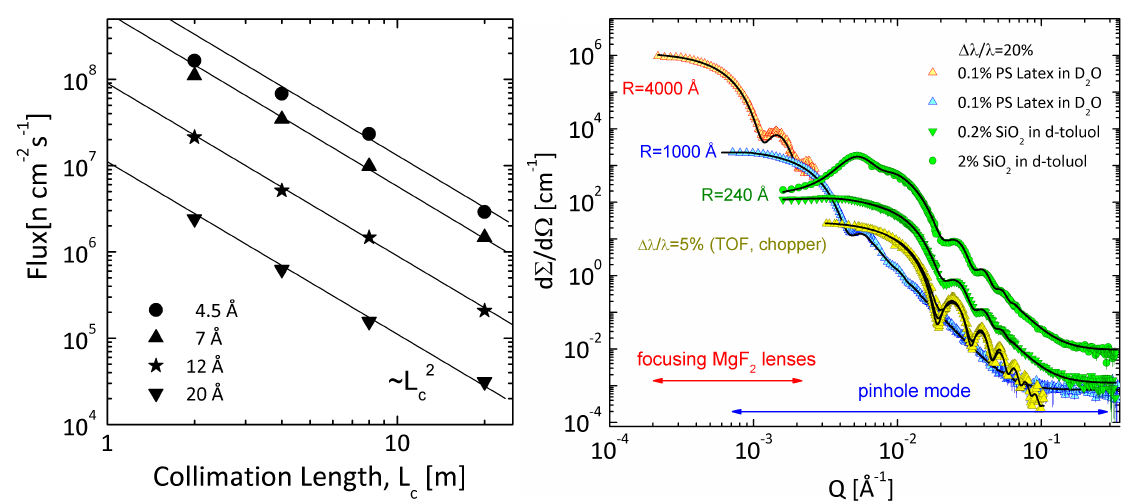
Figure 3: Left: the absolute neutron flux at the sample position; Right: the available range of momentum transfer Q for a selection of instrument configurations (the experimental data are described by model function convoluted with the instrument